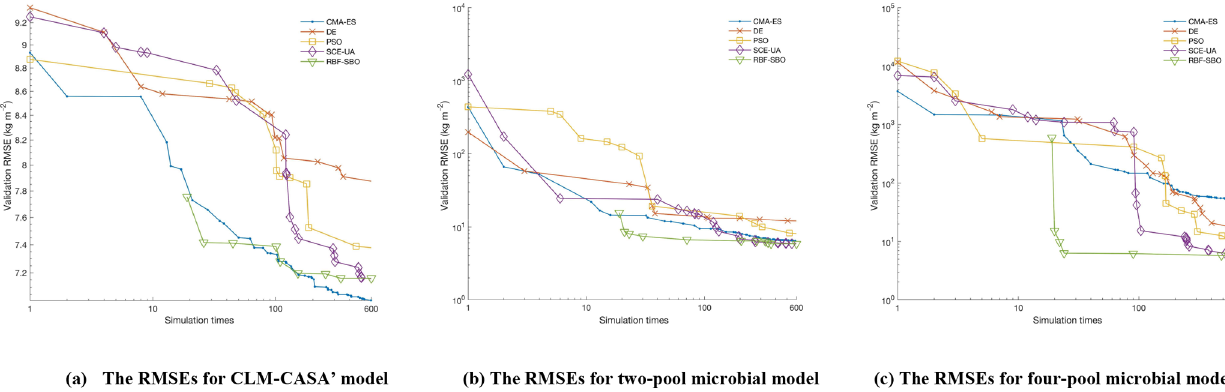
Figure 5. The average RMSEs with the increase of number of simulations and different optimization algorithms: (a) the CLM-CASA’ model, (b) the two-pool microbial model and (c) the four-pool microbial model. Since RBF-SBO requires some initial simulations to start the optimization process, RBF-SBO starts when the x axis value is 19.